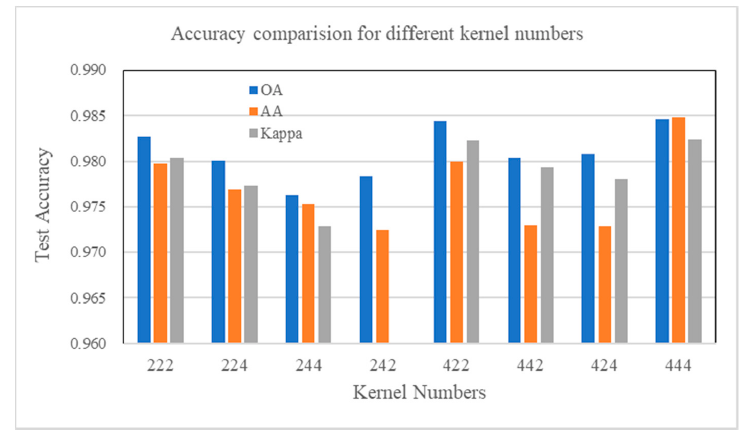
Figure 14. Overall accuracy, average accuracy, and kappa of variation of the S2FEF blocks (convolutional layers).